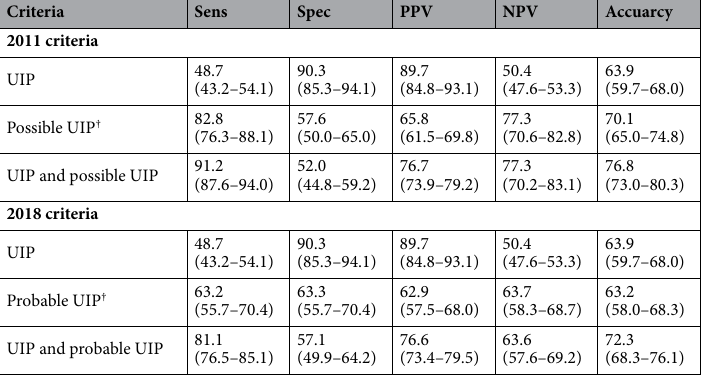
Criteria Sens Spec